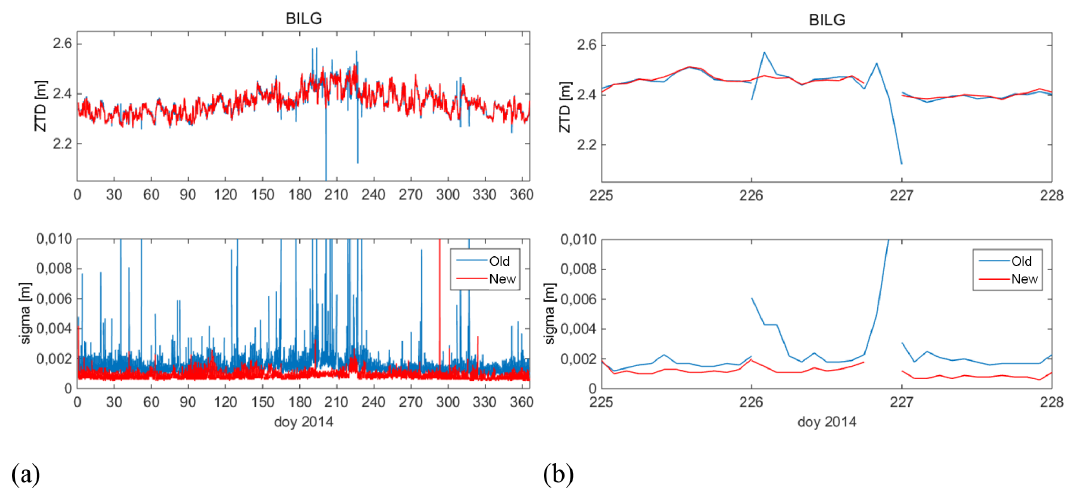
Figure 7. Comparison of ZTD estimates and formal error for the old (blue lines) and new (red lines) baseline strategies. (a) Full time series for station BILG. (b) Zoom-in on period when the old solution had outliers due to a reduction in the number of observations (beginning of day 266) and a gap in the observations (end of day 226) at reference station USDL. The new solution has only a short gap but no outliers.